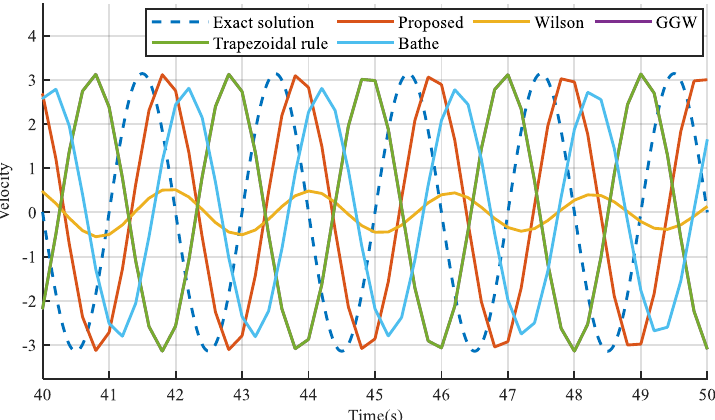
Figure 7. Acceleration responses with the Wilson method, Bathe method, GGW method, trapezoi- dal rule, and the proposed method from 40 to 50 s. Table 1. Computational time of different methods for Problem 4.1. Method\ Δ t